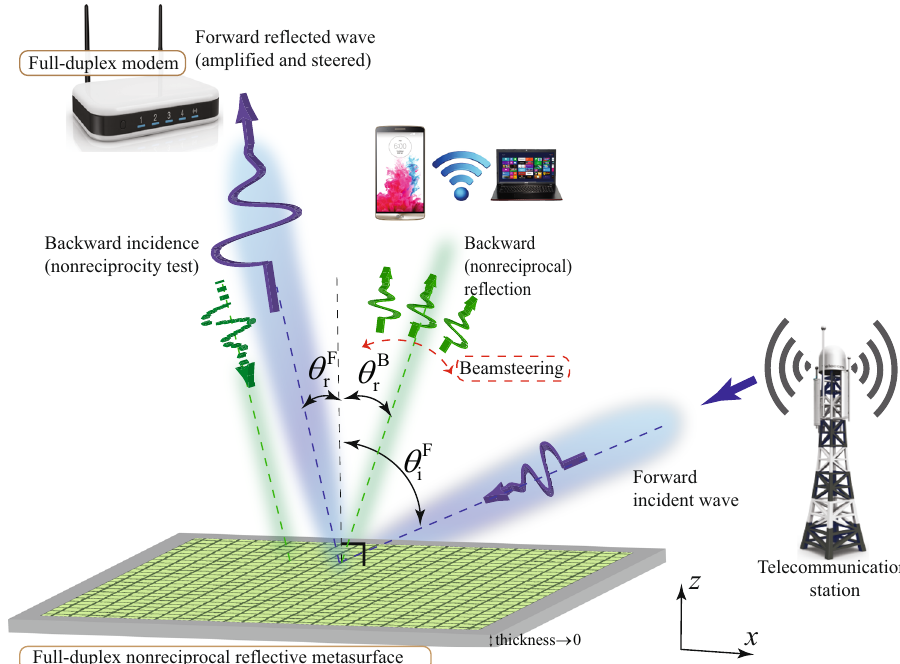
Fig. 2 Metasurface functionality. Full-duplex nonreciprocal re fl ective beamsteering and its application to an advanced full-duplex indoor wireless communication